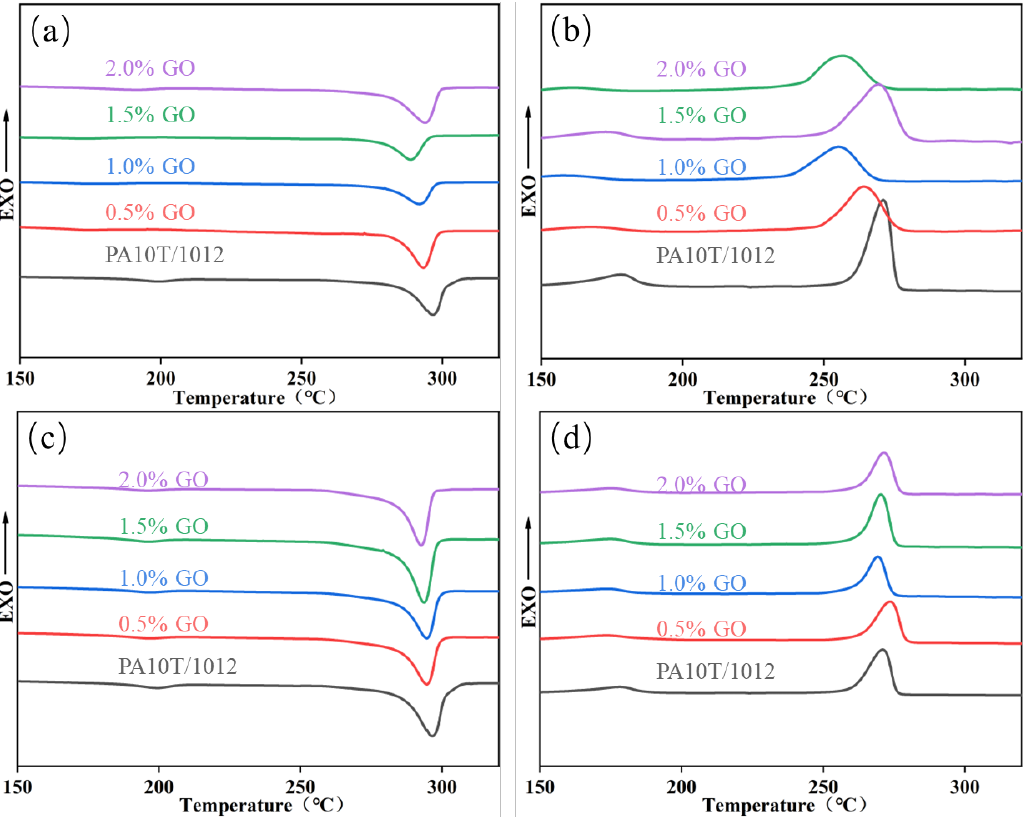
Figure 8. Differential scanning calorimetry (DSC) thermograms: SPA composites ( a ) Secondary heating curve; ( b ) Cooling curve; MPA composites ( c ) Secondary heating curve; ( d ) Cooling curve. Table 3. Test results of some thermal properties of SPA composites and MPA composites.